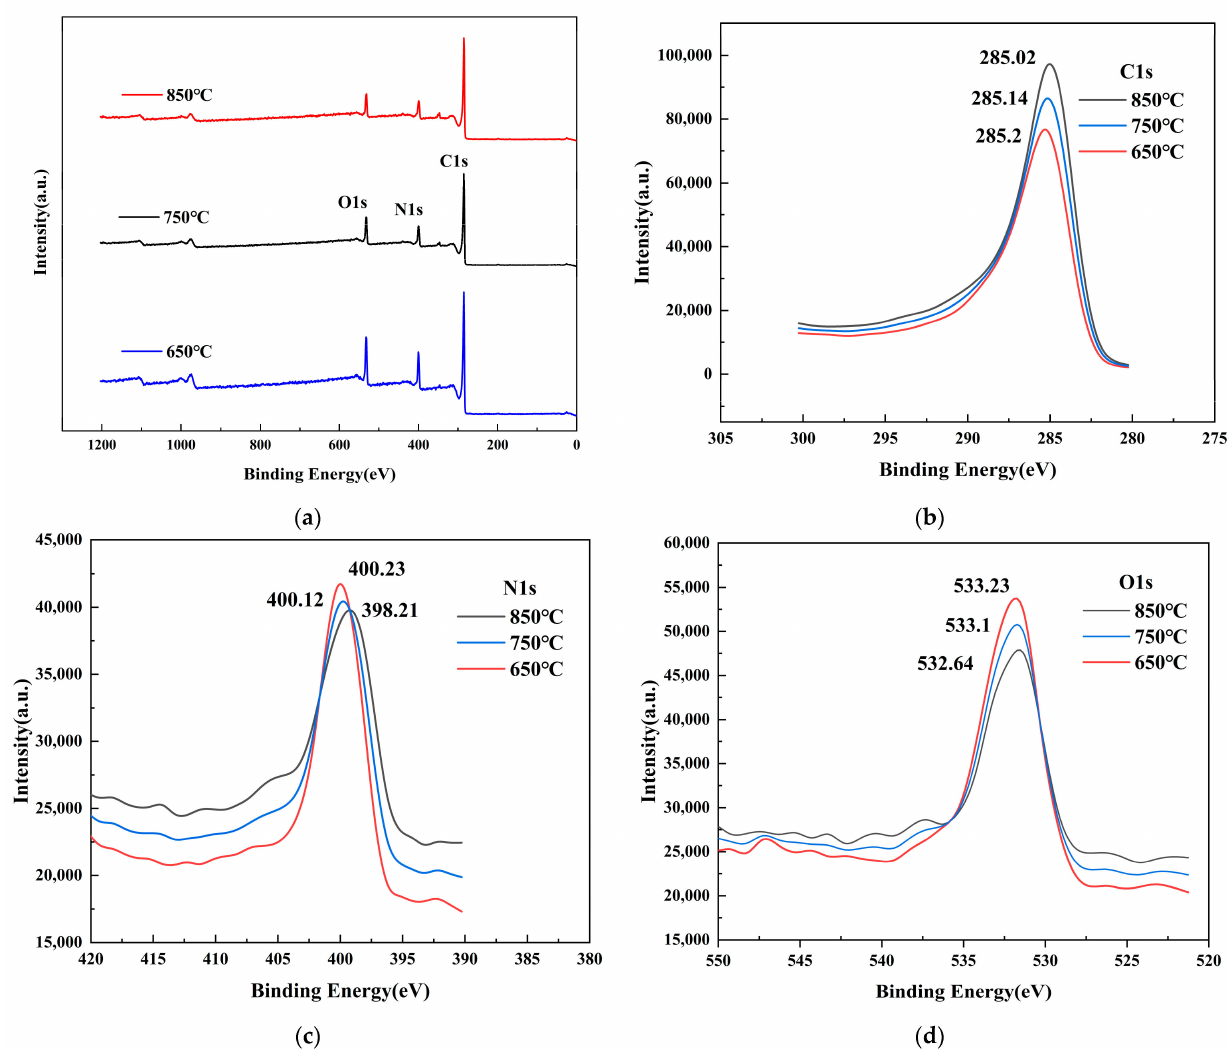
Figure 8. ( a ) XPS spectra of materials; XPS spectra of ( b ) C 1 s, ( c ) N 1 s, and ( d ) O 1